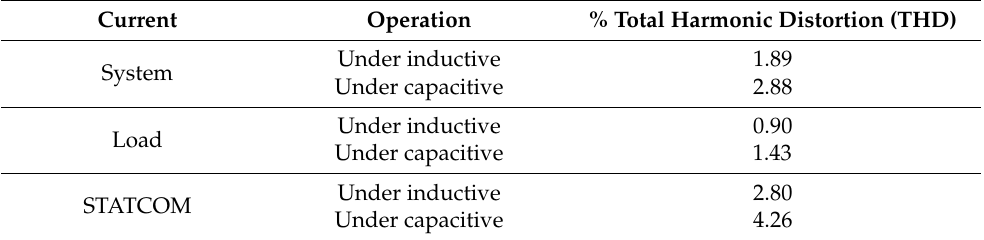
Table 2. THD at various